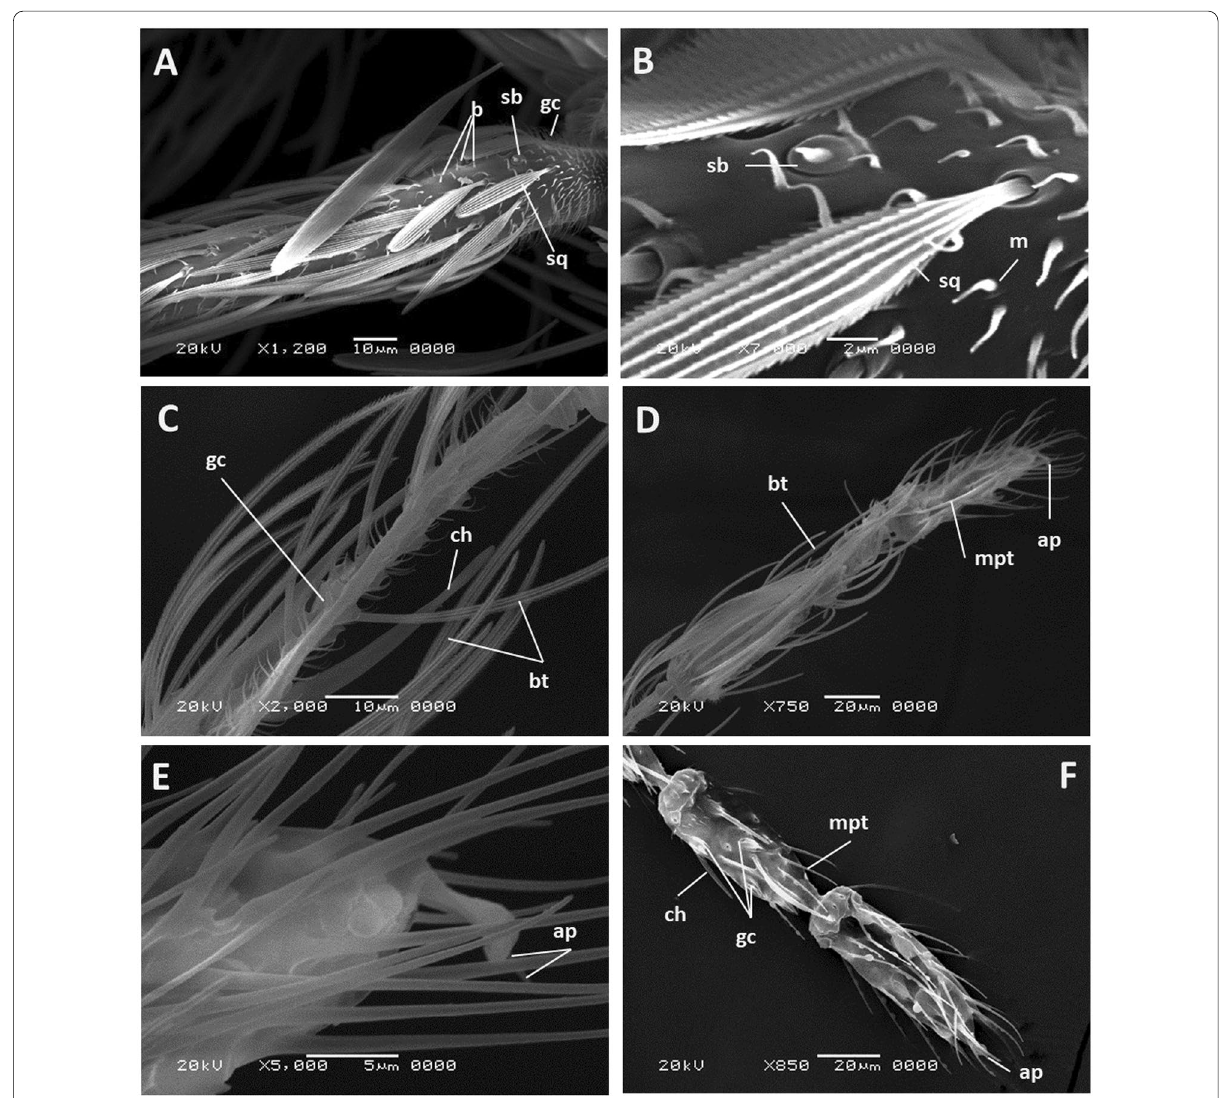
Fig. 3 SEM micrographs of Phlebotomus papatasi flagellomeres. A Flagellomere I of female showing, squamiform sensilla (sq); basiconic (b); short blunt-tipped trichoid (sb); and common grooved coeloconic sensilla (gc). B Higher magnification of female flagellomere I showing, squamiform (sq); short blunt-tipped (sb) sensilla, besides microtrichia (m). C Flagellomere XI of female showing, long blunt-tipped tipped trichoid (bt); common grooved coeloconic (gc); chaetic (ch) sensillum. D Last three flagellomeres of females showing, long blunt-tipped trichoid (bt); medium pointed-tipped trichoid (mpt); chaetic (ch) sensillum; and last antennal flagellomere XIV showing, apical trichoid (ap) sensillum. E The apex of the last flagellomere in higher magnification in the female showing, the apical trichoid sensillum. F Last two flagellomeres in male showing, apical trichoid (ap) sensillum; common grooved coeloconic sensilla (gc); chaetic (ch) sensillum; and medium pointed-tipped trichoid (mpt)